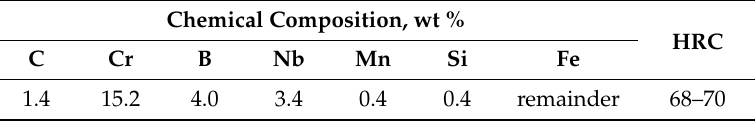
Table 1. Chemical composition and hardness of the tested deposit